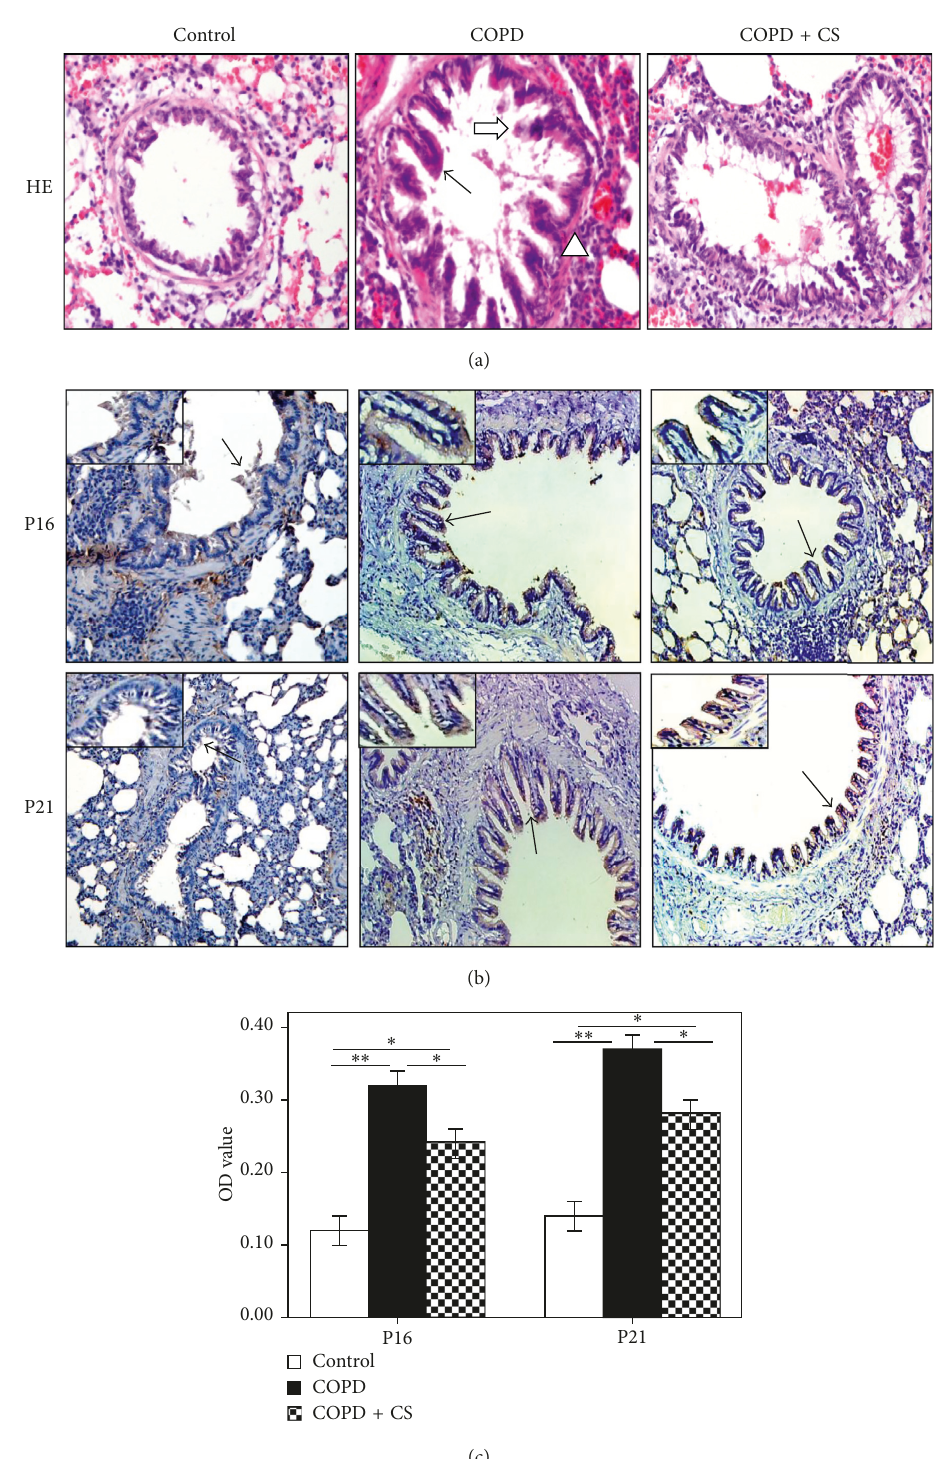
Figure 2: The expression of P16 and P21 in the airway epithelial cells of COPD rat models. (a) The pathological structure changes of airway in COPD rats were observed by HE staining (HE, 200x). In the control group, the airway epithelium structure was complete, and cell fall off, cilia lodging, goblet cell hyperplasia, and phlegm retention were not obvious. In the COPD group, airway epithelial cells fall off partly, and mucosal hyperemia, cilium adhesion or lodging, goblet cell hyperplasia (black arrow), mucus secretion exuberant and large amounts of mucus retention (white arrow), and fibrous tissue hyperplasia (triangle) around the trachea and submucosa were obvious. In the COPD+CS group ( O. sinensis treatment group), in the airway epithelium, cilia lodging, hyperplasia of goblet cells, mucus gland secretion, and submucosal fibrous tissue hyperplasia were also reduced. (b) The expression of P16 and P21 in the airway epithelium of the COPD group and COPD+CS group were detected by IHC (200x). (c) Quantitative analysis of P16 and P21 expression in the COPD group and COPD+CS group.